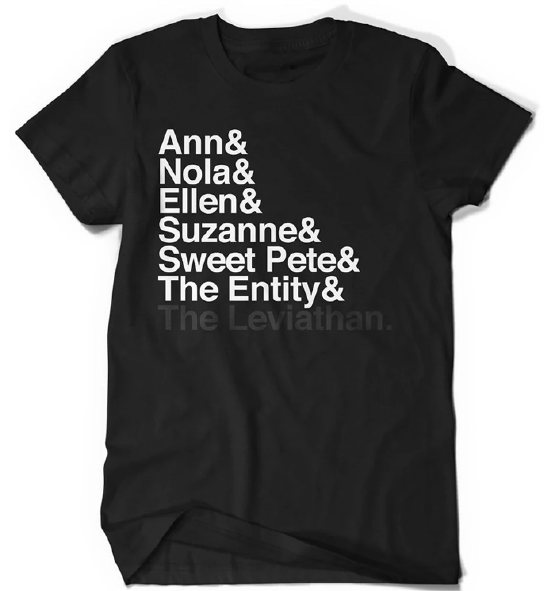
Figure 2. Official Merchandise from TBSCC podcast featuring the hosts’ ongoing fascination with author Ann M. Martin and the various ghostwriters of the series.